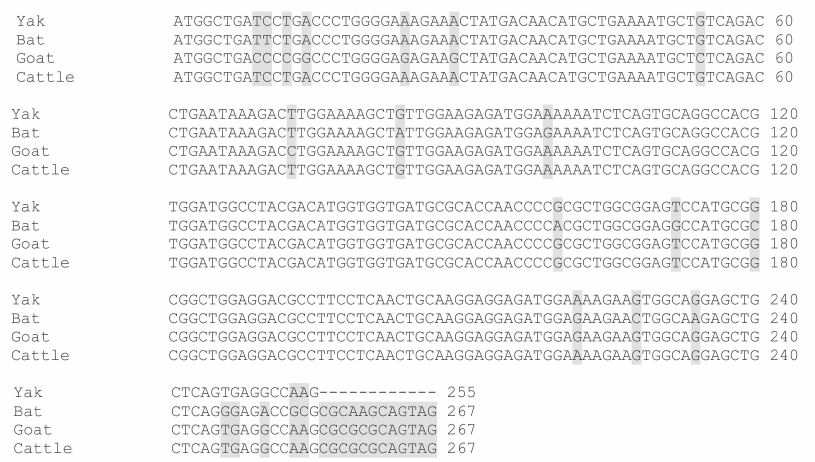
Figure 4. Multiple alignment of full length sequences of yak TSEG2 protein with bat, goat, and cattle. Dissimilar amino-acids are represented by shaded boxes.